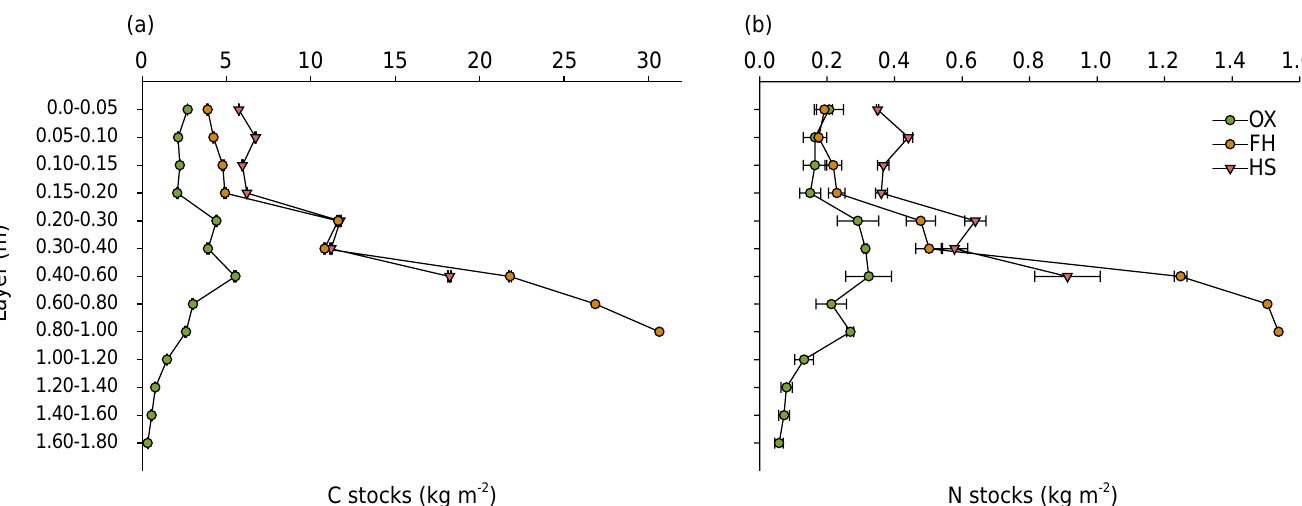
Figure 1. Total carbon (a) and nitrogen (b) stocks in a Humic Hapludox (OX), a Fluvaquentic Humaquepts (FH), and a Typic Haplosaprists